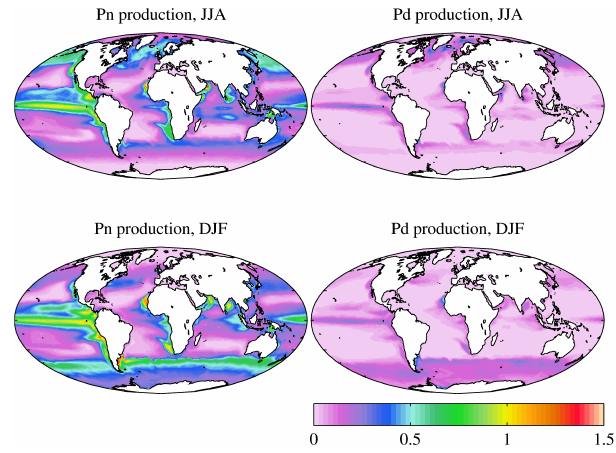
Fig. 28. Simulated non-diatom (left) and diatom (right) primary production for northern summer (June-July-August; top) and northern winter (December-January-February; bottom). Production in gCm − 2 d − 1 .